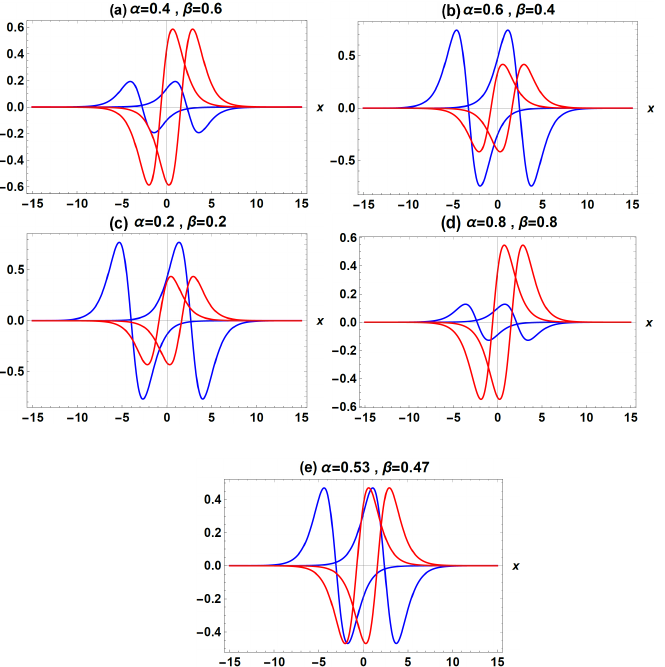
Figure 3. Modes of the binary waves of θ 1 ( x , y , t ) in (14) for different values of the nonlinearity and dispersion factors ( a ) α = 0.4, β = 0.6. ( b ) α = 0.6, β = 0.4. ( c ) α = 0.2, β = 0.2. ( d ) α = 0.8, β = 0.8. ( e ) α = 0.53, β = 0.47.